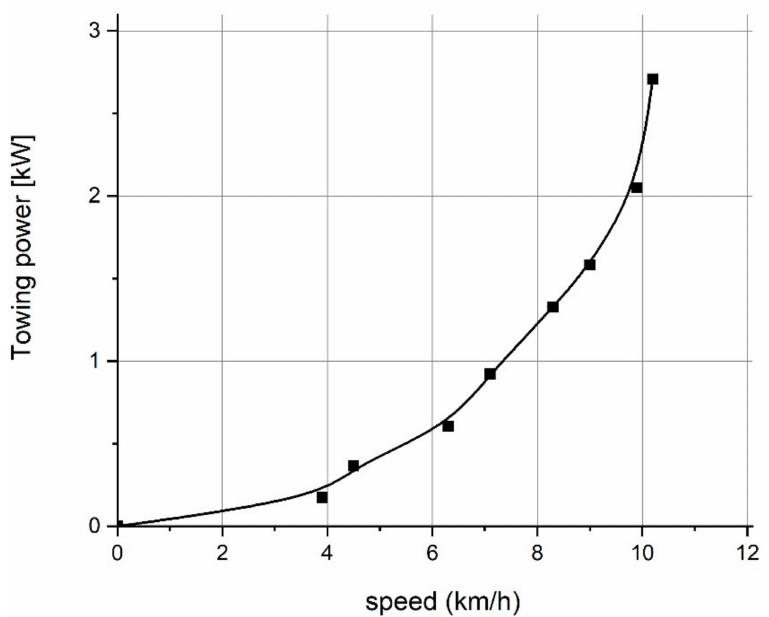
Figure 2. Towing power diagram—for calm water